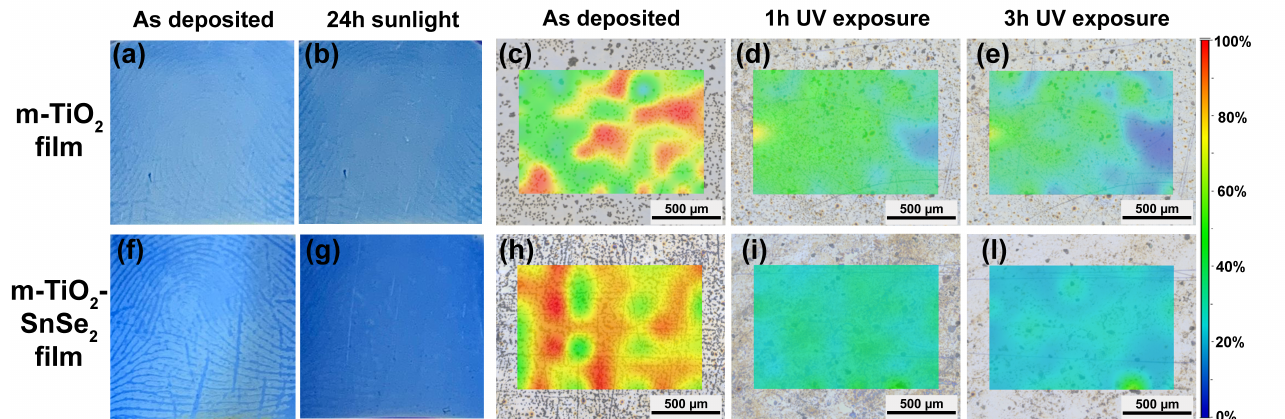
Figure 12. Photographs of human fingerprints on m-TiO 2 ( a , b ) and m-TiO 2 -SnSe 2 ( f , g ) films before and after exposure to sunlight in air for 24 h. Infrared images of a human fingerprint deposited on m-TiO 2 ( c – e ) and m-TiO 2 -SnSe 2 ( h – l ) films. The images were taken by integrating the area of the -CH 2 stretching bands of stearic acid. The fingerprint was produced by immersing the finger in a stearic acid solution. The infrared images were detected at different times: as deposited, after 1 h and after 3 h of UV exposure, respectively. The color scale bar shows the intensity scale in false colors; the red and blue colors represent the highest and the lowest absorbance of the infrared signal,